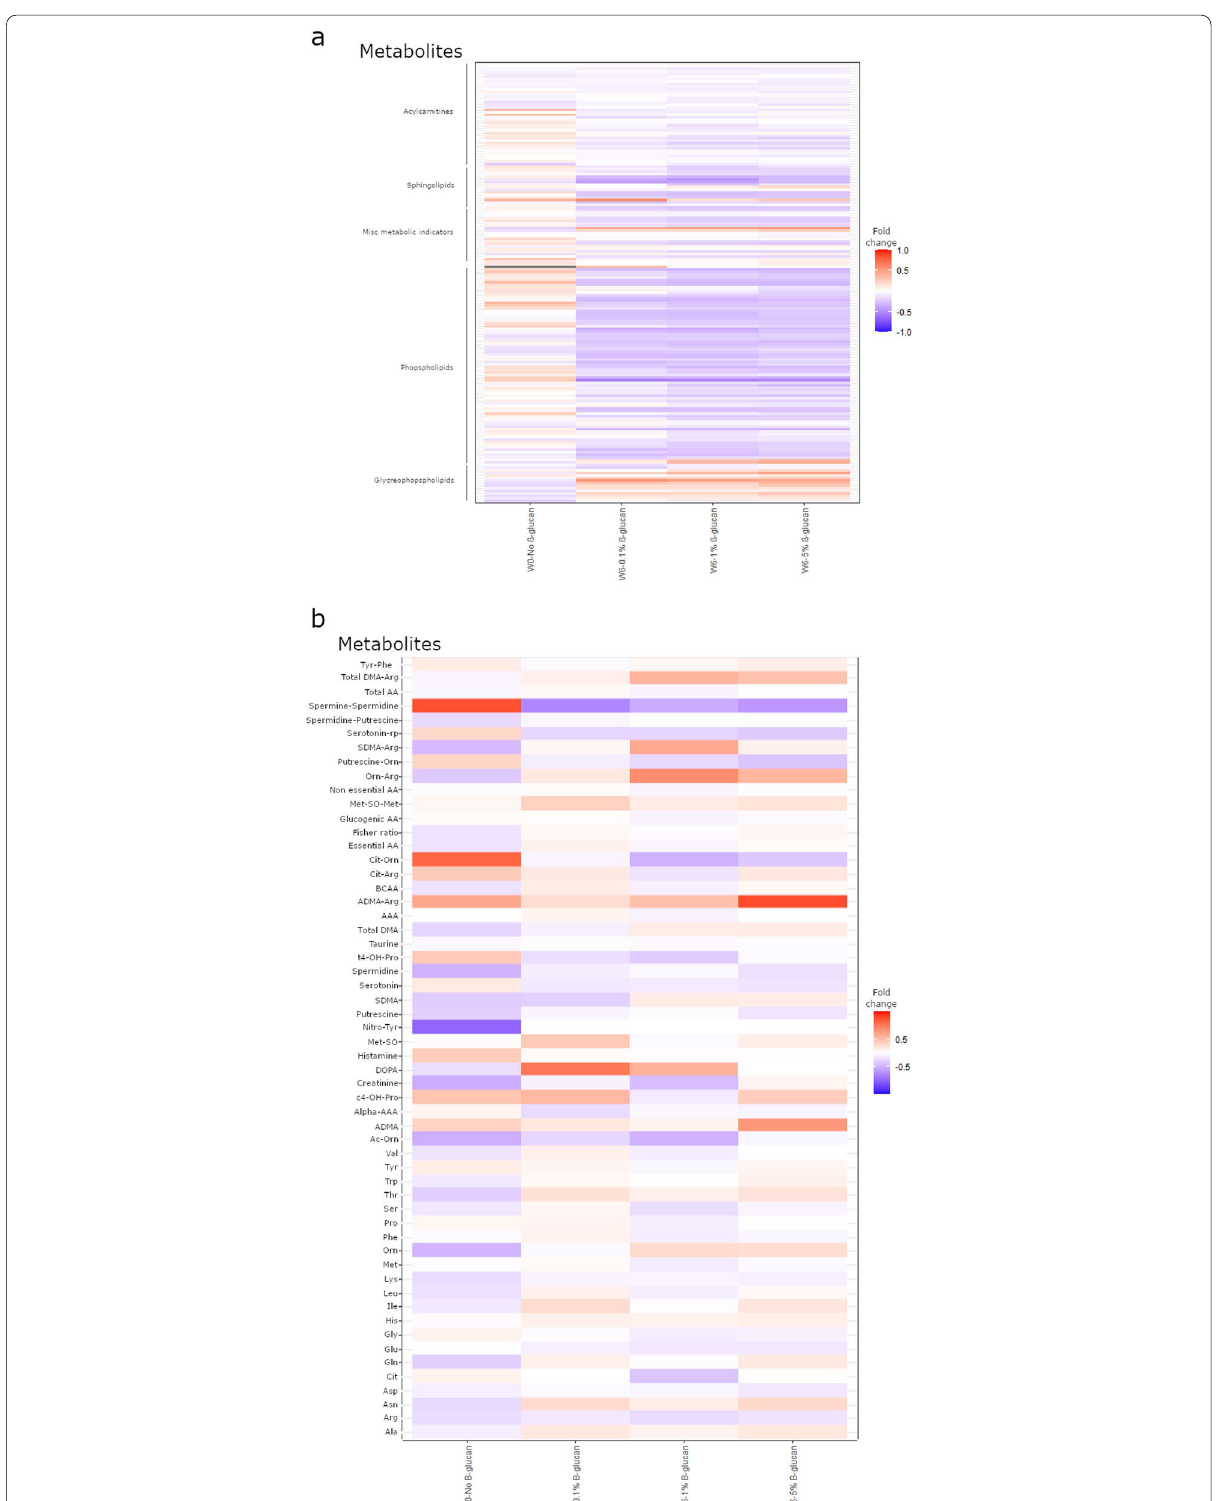
Fig. 4 Heatmap showing the relative abundance of the serum’s metabolites compared to the control at week 6 (W6‑ 0.0% β‑glucan) using pairwise Wilcoxon rank sum tests. Only samples that are significantly different from the control are shown and the colour of the square indicates the intensity of the change. A : LC samples. B : FIA